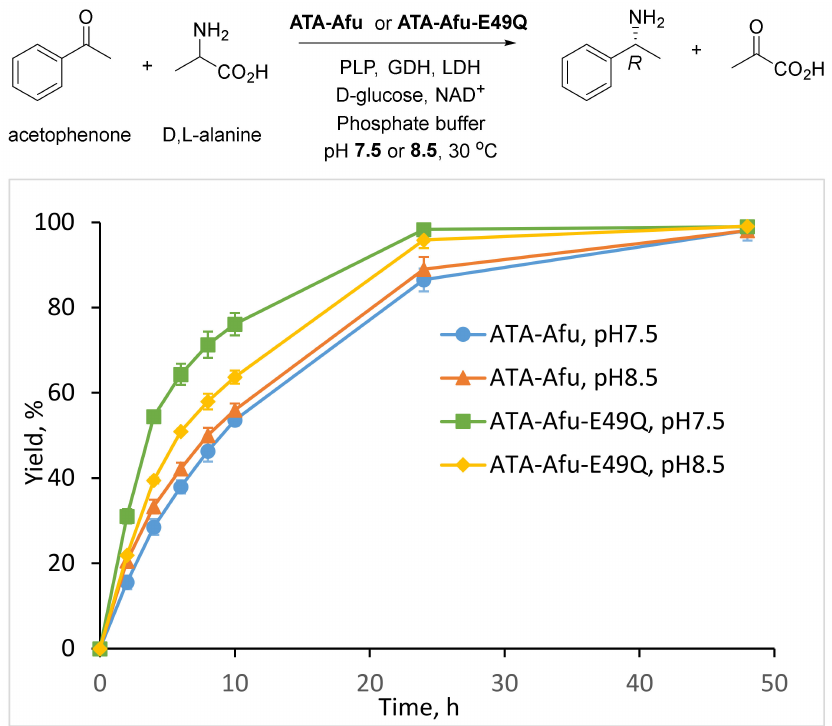
Figure 6. Asymmetric synthesis of ( R )-PEA from acetophenone. Assay conditions for asymmetric synthesis: 10 mL final volume, 50 mM phosphate buffer at pH 7.5 or 8.5, 0.1 mM PLP, 5 mM ketone, 100 mM D,L-alanine, NAD + (1 mM), GDH (1 U mL − 1 ), D-glucose (50 mM) and LDH (3 U mL − 1 ), DMSO 5%, 5 mg purified enzyme, 30 ◦ C under